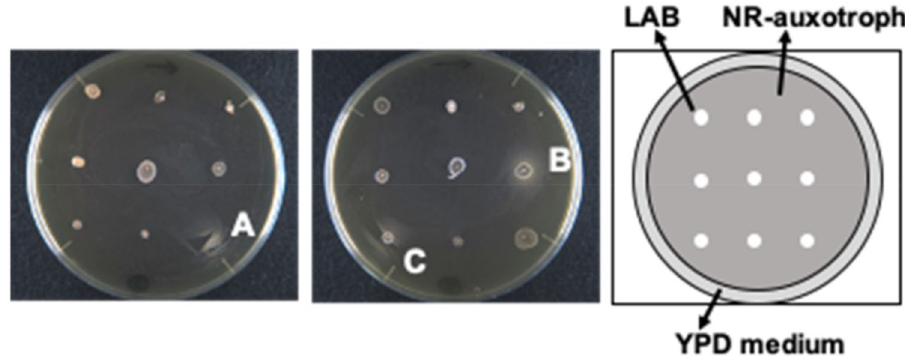
Figure 1. Screening of LAB for their extracellular production of NMN or NR with NR-auxotrophic yeast. LAB cells from their colonies were inoculated onto YPD plates spread with NR-auxotrophic yeast (1.0 × 10 6 cells) and cultivated at 30 °C for several days. If the LAB produce NMN or NR outside of the cells, a halo of NR-auxotrophic yeast should be observed around the colony of the LAB as shown in the photos (A: RD011727; B: RD012353; C: